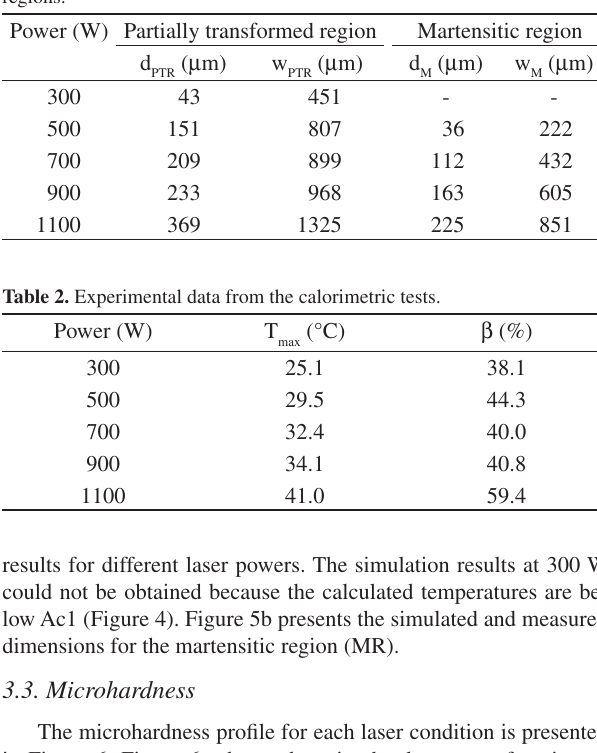
Figure 3. Scanning electron microscope images: a) General aspect of the hardened zone (700 W); b) interface between base material and PTR (700 W); c) martensite laths inside the hardened region (1100 W); d) partially superposed tracks at 900 W with arrow identifying the tempered region; and e) tempered martensite inside the overlapped region (zoomed-in view of the region indicated by an arrow in Figure 3d). Table 1. Measurements of average depth (d) and width (w) of the transformed interface in the laser tracks for the partially transformed and the martensitic regions.